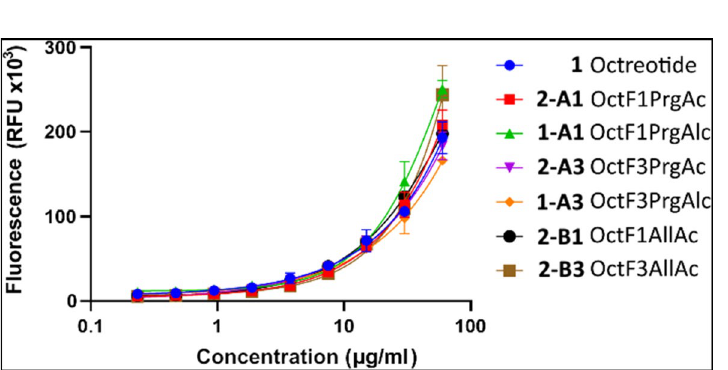
Figure 6. Fluorescence in Relative Fluorescence Units (RFU) of the TAMRA conjugated octreotide variants bound to the A549 cells against their concentration during incubation. The fluorescence for all variants rises almost equally with increased concentration indicating the binding of all variants to the cells with similar